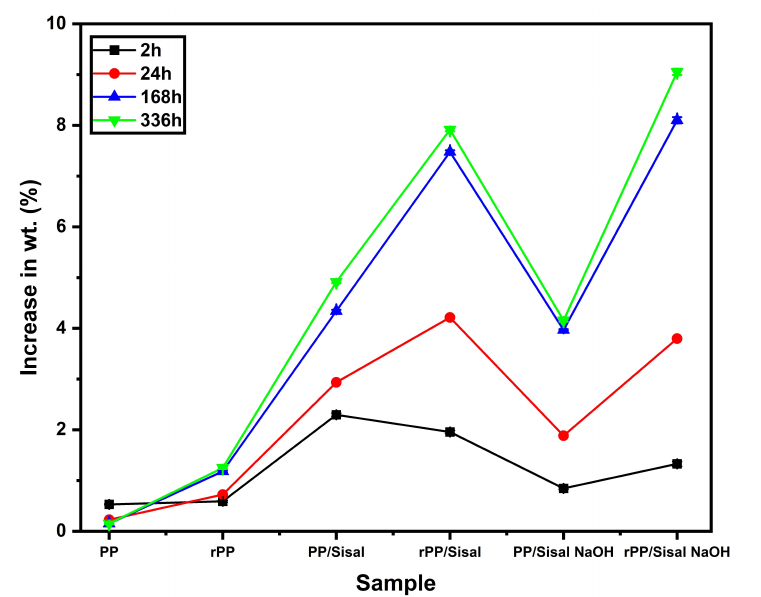
Figure 4. Water absorption results for PP, rPP and bio-based